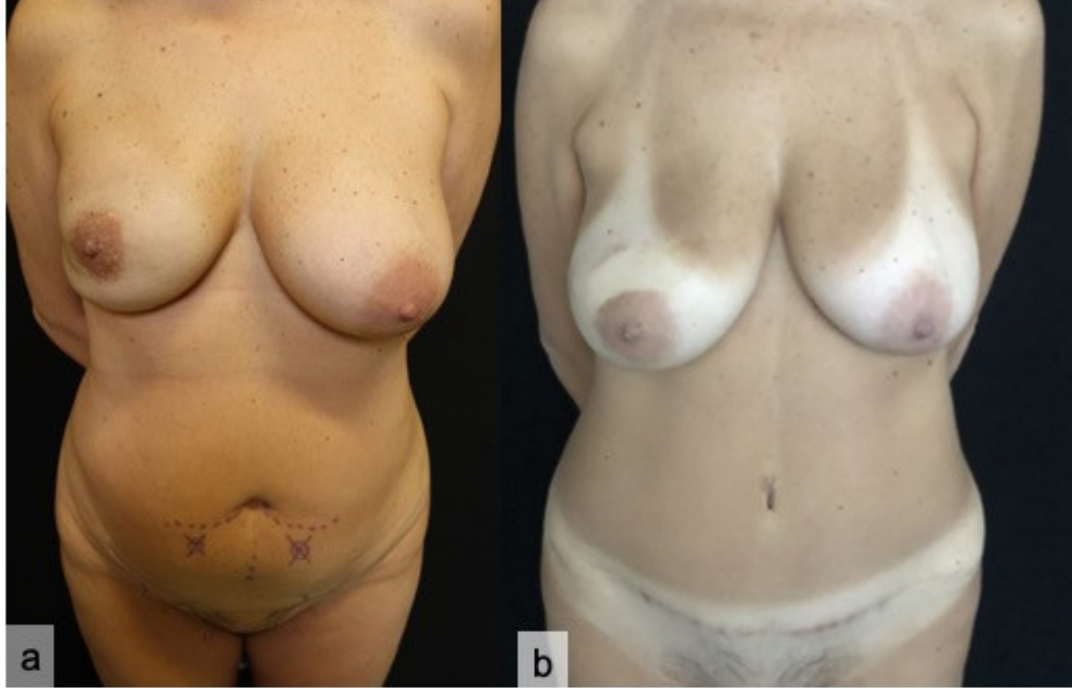
isolate the inferior epigastric pedicle with its dominant perforator (arrow). Microgrid was employed to measure perforator caliber.